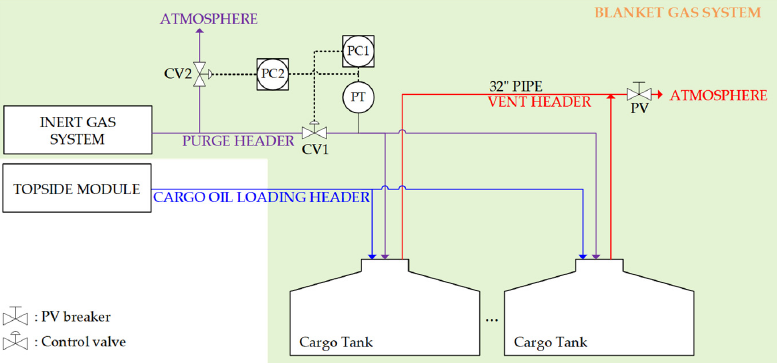
Figure 2. Configuration of a typical blanket gas system (Case